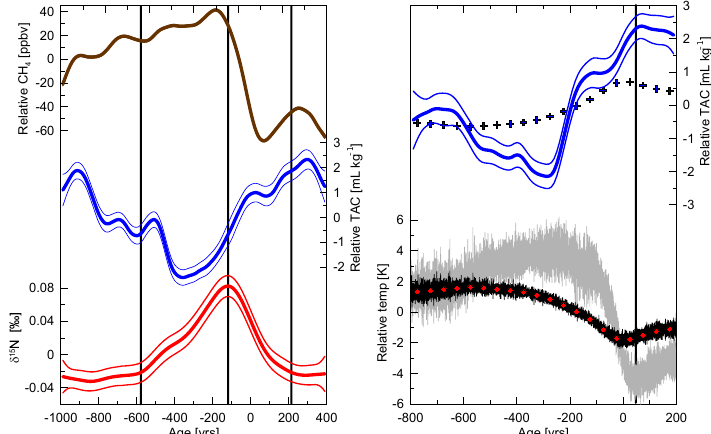
Figure 10. Stacked data over the onsets of all DO events except DO events 2 and 25 (Table 4). Left: red – the stacked δ 15 N model data (Kindler et al., 2014); blue – the TAC; brown – CH 4 . Full lines represent the spline; thin lines the 1 σ error range. Note that the variability in the stacked concentration only refers to the analytical error and not the variability between different DO events. Grey lines indicate the start, the maximum and the end of the δ 15 N signal. All three are given on AICC2012 gas age scale. Right: running mean over the modeled bubble close-off temperature (Kindler et al., 2014) in black; red squares indicate a 50-year mean. Grey: the modeled surface temperature. Blue crosses represent the calculated TAC values dependent on bubble close-off temperature only. The blue lines represent the measured TAC on ice age scale. Note that the amplitude of the TAC response differs for the left and right plot, since the stack was established on a different age scale and thus not over the same time windows and with different starting points. The grey line indicates the onset of the surface temperature warming.